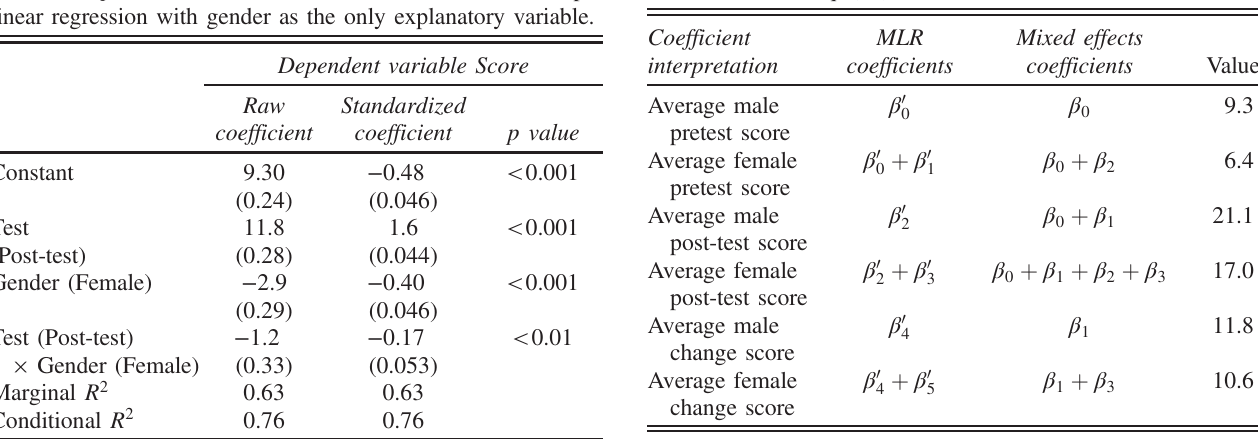
TABLE IV. Quantitative comparison of simple linear regression coefficients [see Eqs. (10a) – (10b), (14)] and mixed effects coefficients [see Eq.